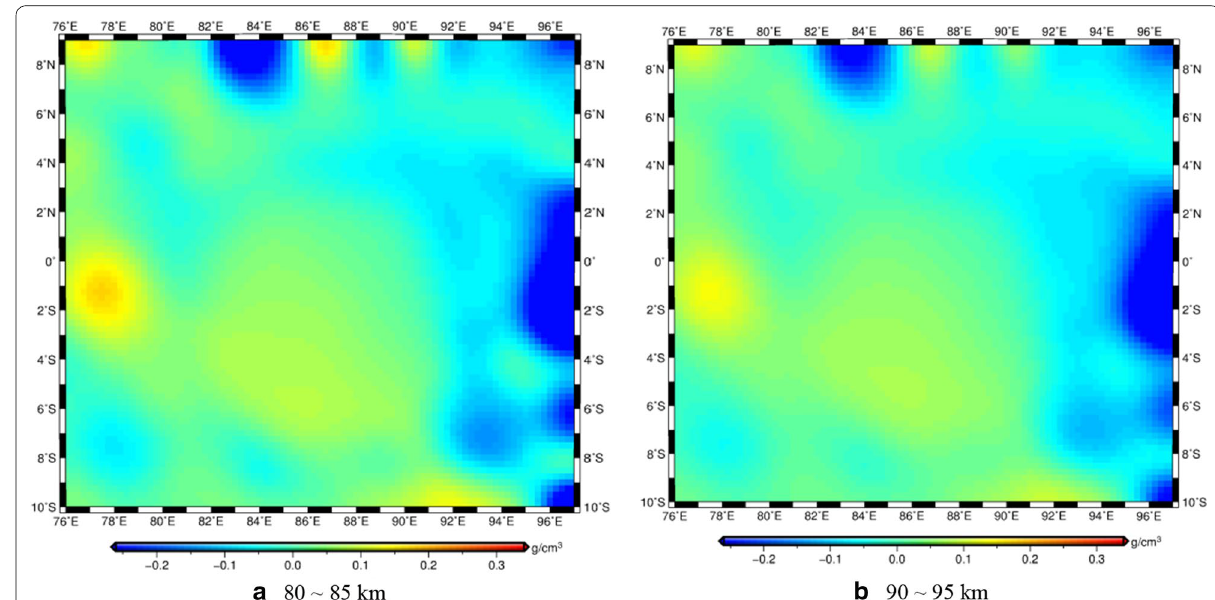
Fig. 18 Relative density distribution for different depths at Mare Smythii area, a and b are 80 ~ 85 km, 90 ~ 95 km, respectively